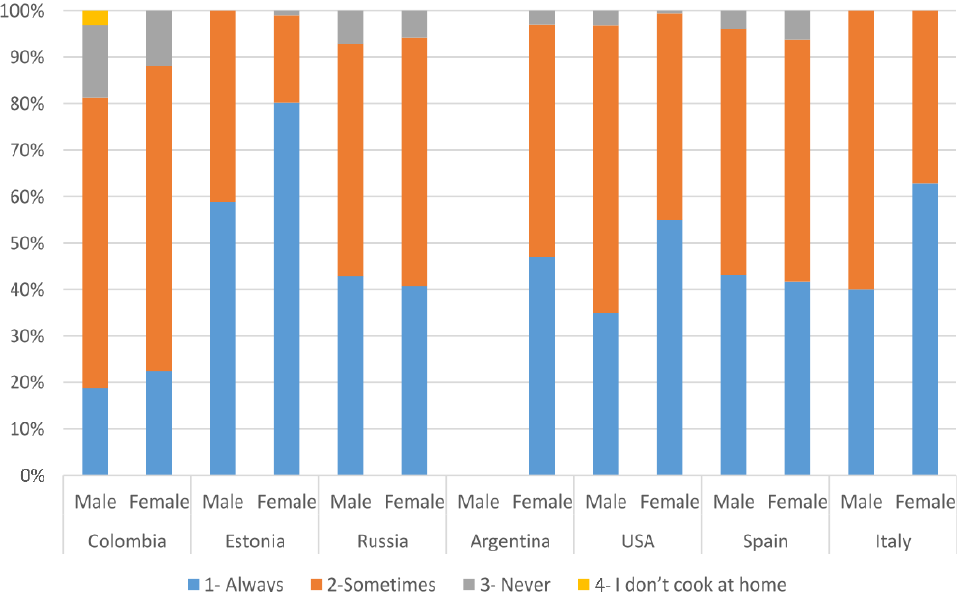
Figure 1. When you cook at home, do you usually save your leftovers? Results presented for women and men in each country, by percentage.